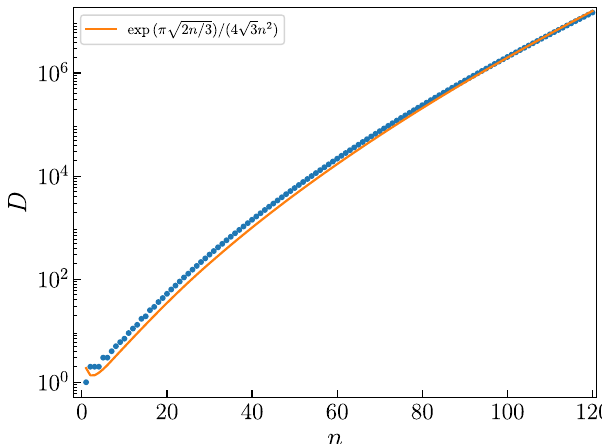
FIG. 6. Total number of different degeneracies D versus n (symbols). The curve is the number of integer partitions of n divided by n